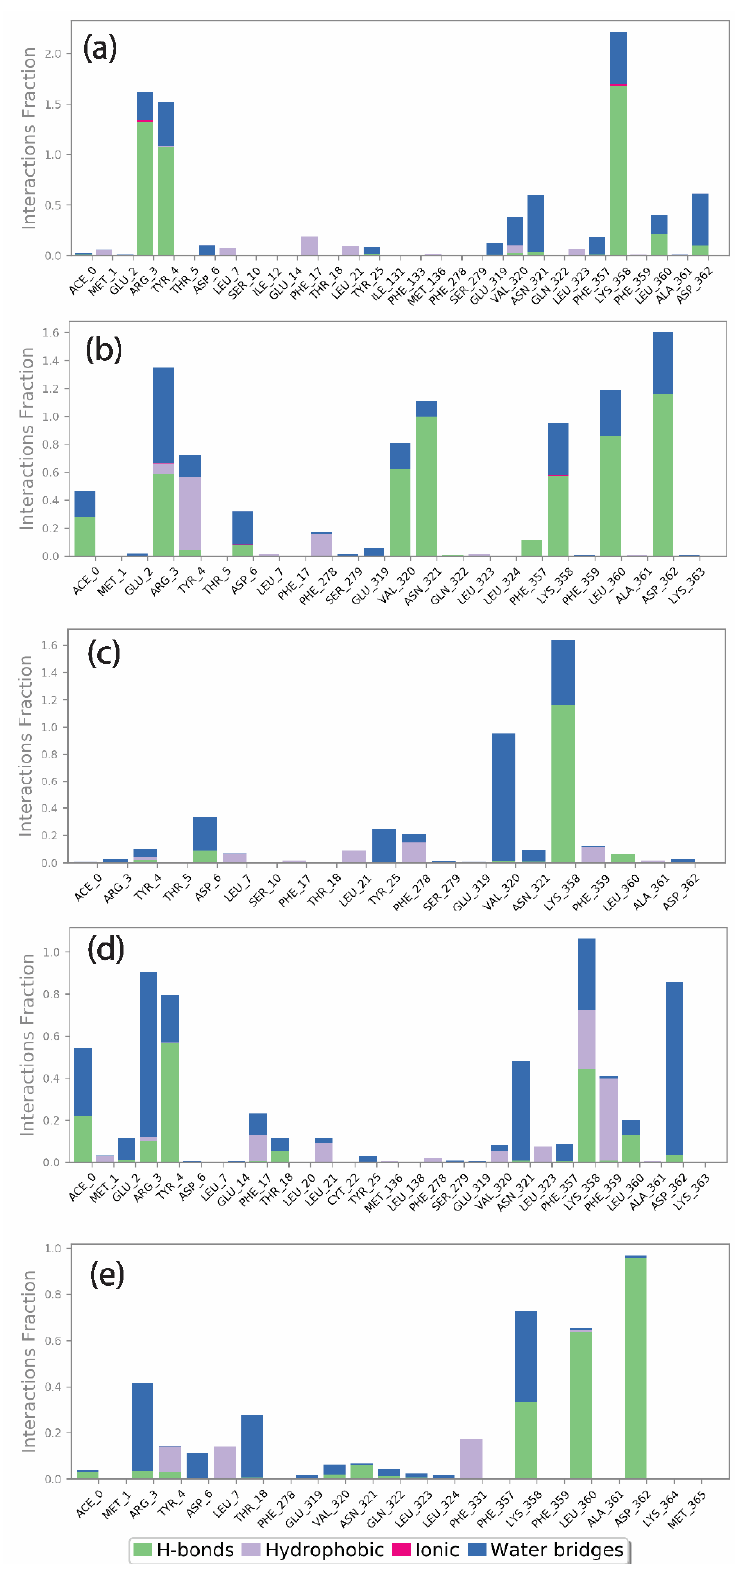
Figure 6. Protein–ligand interactions mapping for viral protein with selected natural compounds over the 100 ns simulation. ( a ) Gallicynoic Acid F, ( b ) H2 Erythro ‐ Neopterin, ( c ) Nigcollin C, ( d ) NPA024545, and ( e ) Vaccinol M.